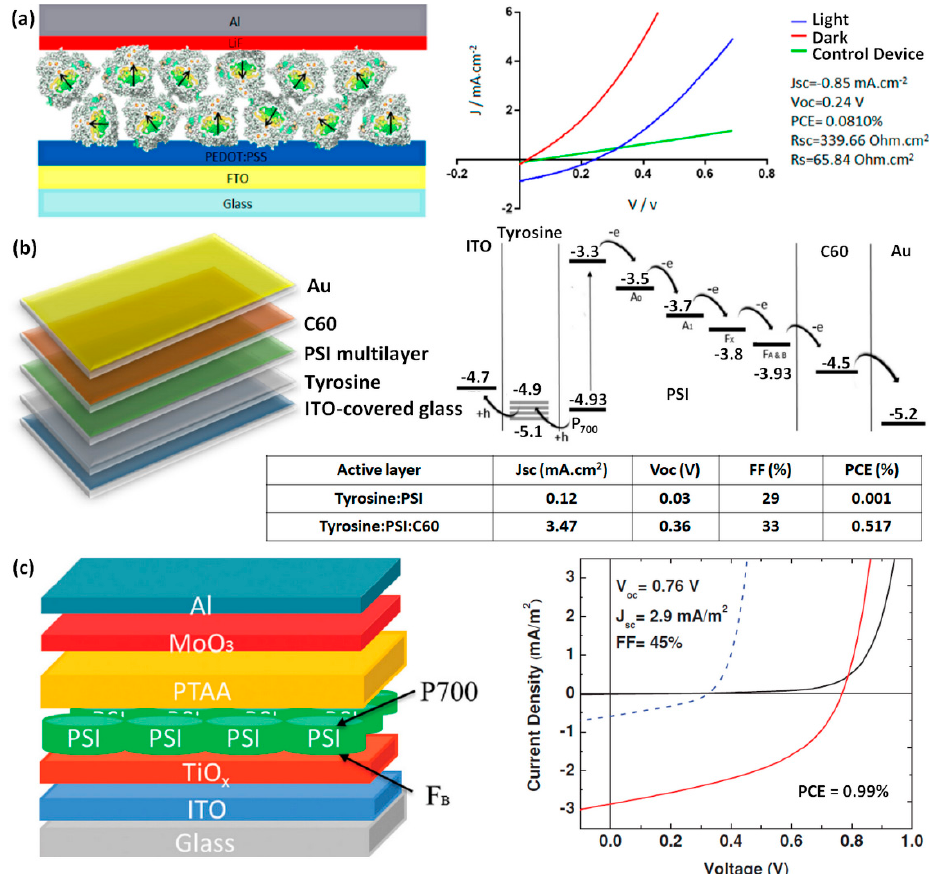
Figure 5. Schematic representations of device architectures and photovoltaic properties of the PSI-based OSCs fabricated in ( a ) Reference [28], ( b ) Reference [29], and ( c ) Reference [32]. Reprinted with permission from References [28,29,32]. Copyright 2017 American Chemical Society. Copyright 2017 Elsevier. Copyright 2014 John Wiley and Sons.